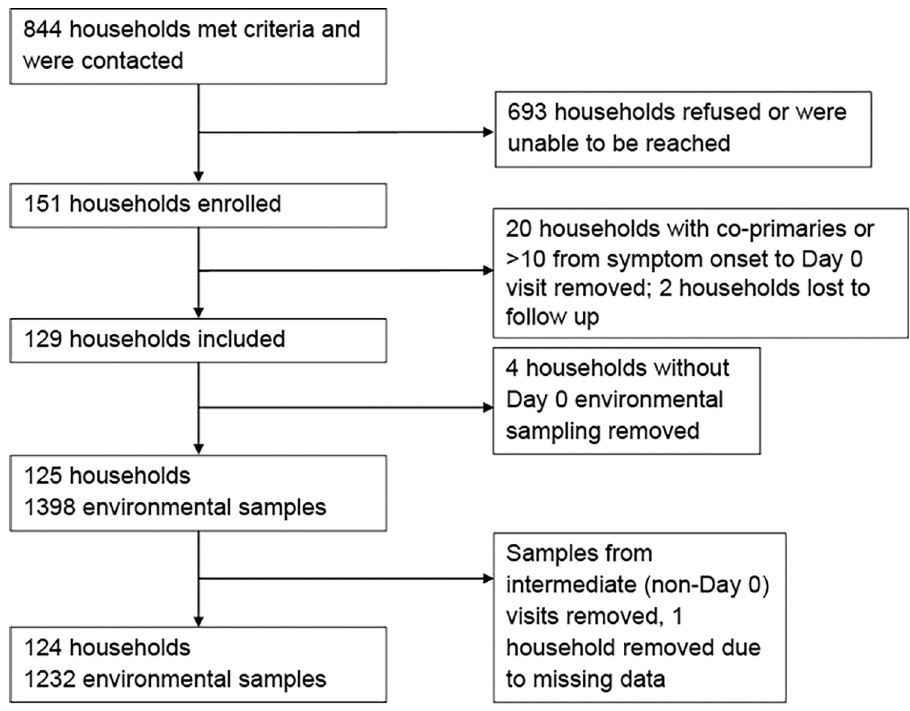
Fig 1. Recruitment, enrollment, and exclusion of households and environmental samples. Of 844 contacted households meeting study criteria, 151 households were enrolled. Households with co-primaries or > 10 days from symptom onset to Day 0 visit were removed. Two households were lost to follow up. Only households with environmental samples and only environmental samples from Day 0 were included in the final analysis.